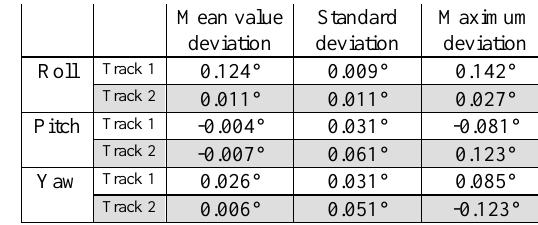
Table 1. Accuracy of the relative pose estimation method tested on real